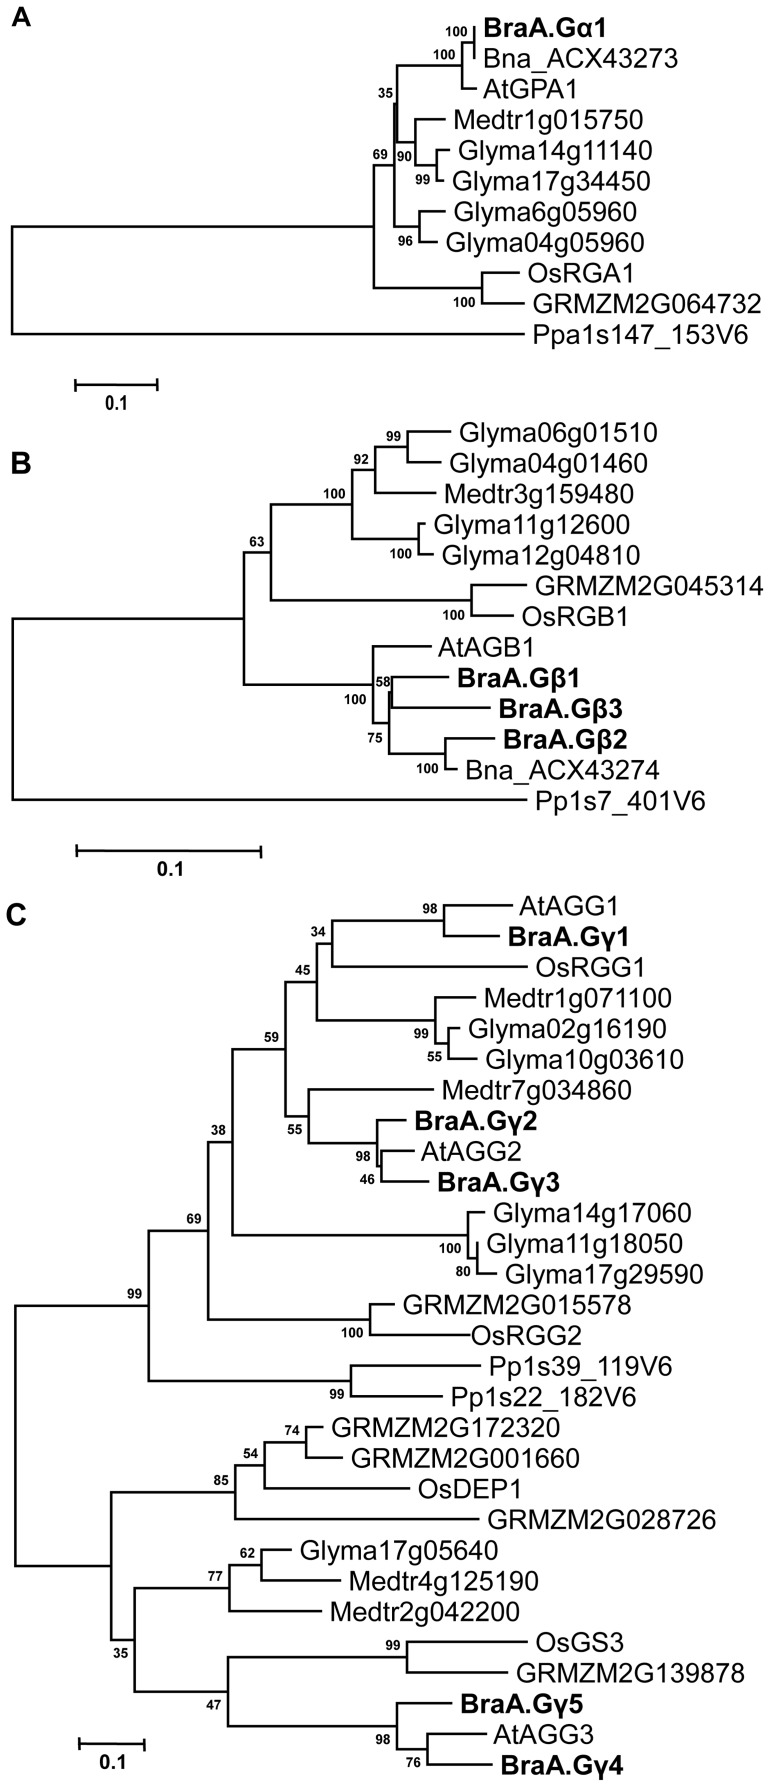
Phylogenetic relationship of G-protein subunits of B. rapa.The phylogenetic analysis of (A) Gα, (B) Gβ, and (C) Gγ proteins of B. rapa (Bra), A. thaliana (At), O. sativa (Os), Glycine max (Glyma), Brassica napus (Bna), Zea mays (GRMZM), Medicago trunculata (Medtr) and Psycomitrella patens (Pp) was performed using neighbor-joining method in MEGA5 (Tamura et al., 2011). The values above the branches represent bootstrap percentage (1,000 replicates) of replicate trees in which the associated proteins clustered together. The tree is drawn to scale, with branch lengths measured in the number of substitutions per site. The B. rapa G-proteins are represented in bold letters.